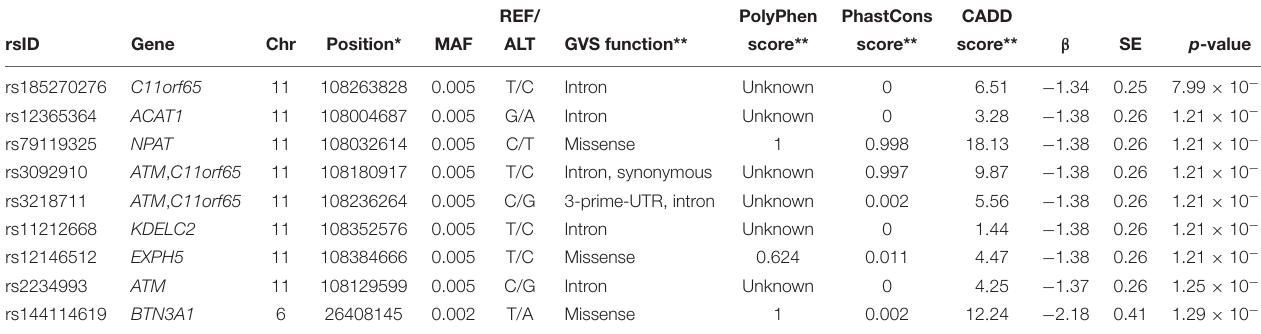
TABLE 2 | Significant variants from the association analysis in the ERF study. REF/ PolyPhen PhastCons